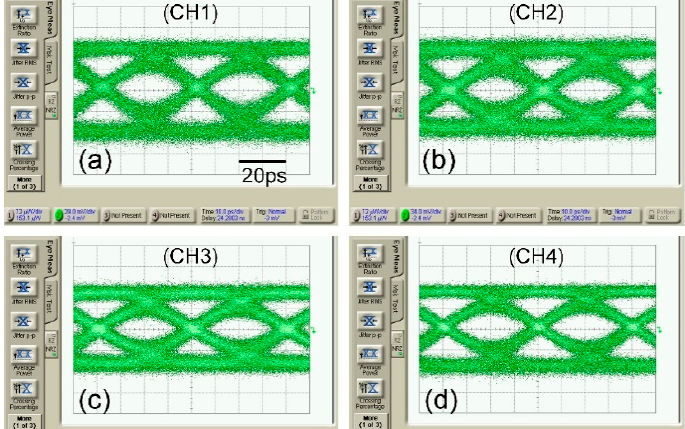
Figure 9. 25 Gb/s eye diagram of WDM transmitter with different wavelengths: ( a ) 1554 nm, ( b ) 1556.4 nm, ( c ) 1558.8 nm, ( d ) 1561.2 nm.